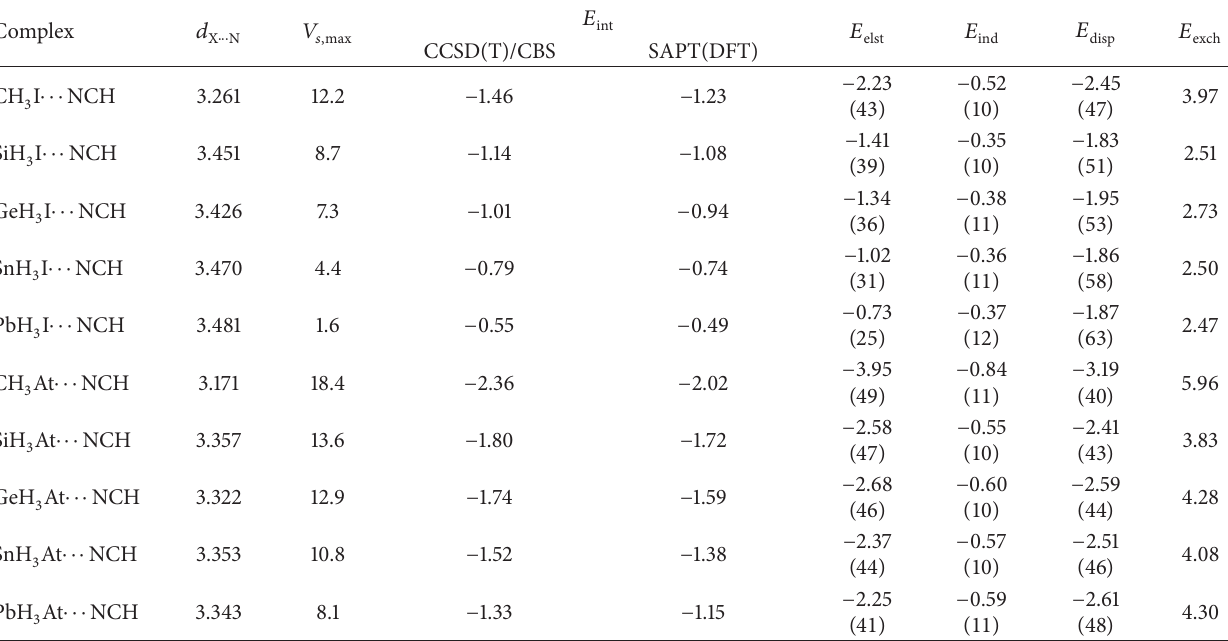
Table 1: Distance between the X and N atoms ( 𝑑 X ⋅⋅⋅ N ; in ˚A), maximal value of electrostatic potential in the 𝜎 -hole region on the X atom ( 𝑉 𝑠, max ; in kcal/mol), CCSD(T)/CBS and SAPT(DFT) interaction energies between MH 3 X and HCN ( 𝐸 int ; in kcal/mol), and SAPT(DFT) principal interaction energy components ( 𝐸 elst , 𝐸 ind , 𝐸 disp , and 𝐸 exch ; in kcal/mol) for the investigated MH 3 X ⋅⋅⋅ NCH complexes. The percentage of each attractive SAPT(DFT) component relative to the total attraction is given in